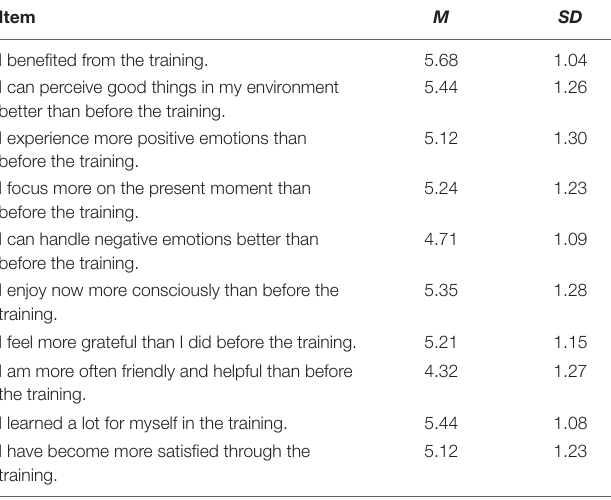
TABLE 8 | Subjective training success 19–25 weeks after training. Item M